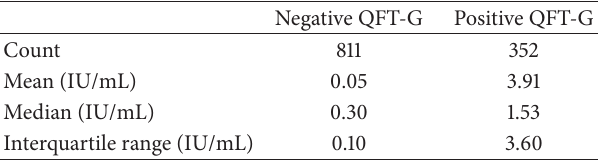
Table 2: Mean, median, and interquartile range for TB